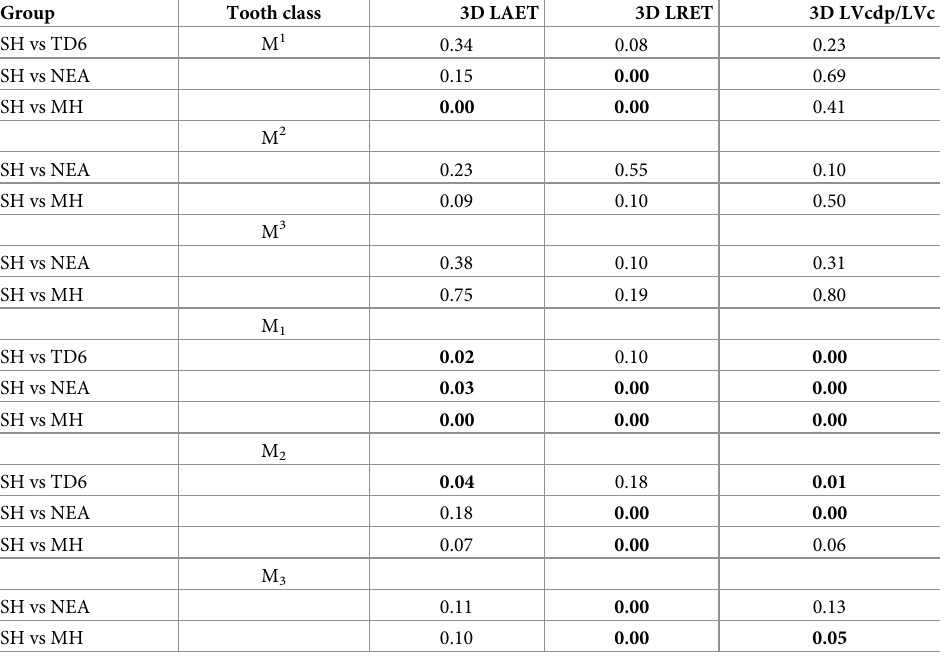
Table 7. Mann-Whitney comparative statistical test (significant p values (0.05) in bold) for the 3D measurements (lateral enamel thickness) in SH, and comparative samples ( H . antecessor , H . erectus , Neanderthals and modern